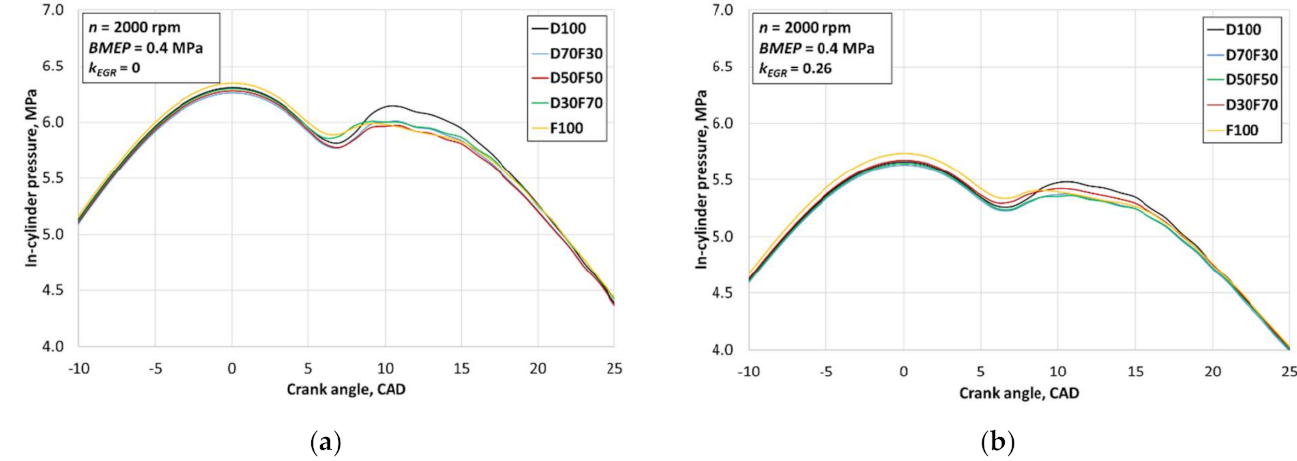
Figure 6. In-cylinder pressure depending on the fuel composition with ( a ) EGR off and ( b ) EGR on. The exhaust flue temperature (Figure 7) and turbocharger pressure (Figure 8) mea- sured during the experimental research confirmed the results of the numerical analysis of the combustion process. The exhaust temperature was observed to have a tendency to increase (1–2%) both with EGR off and EGR on for all engine loads (BMEP = 0.3 MPa, 0.4 MPa and 0.6 MPa) when increasing the chicken fat concentration in the fuel from 50% to 100%. The flue gas temperature graph correlates with ~1% turbocharger pressure. A higher exhaust energy volume was due to a later combustion of the chicken